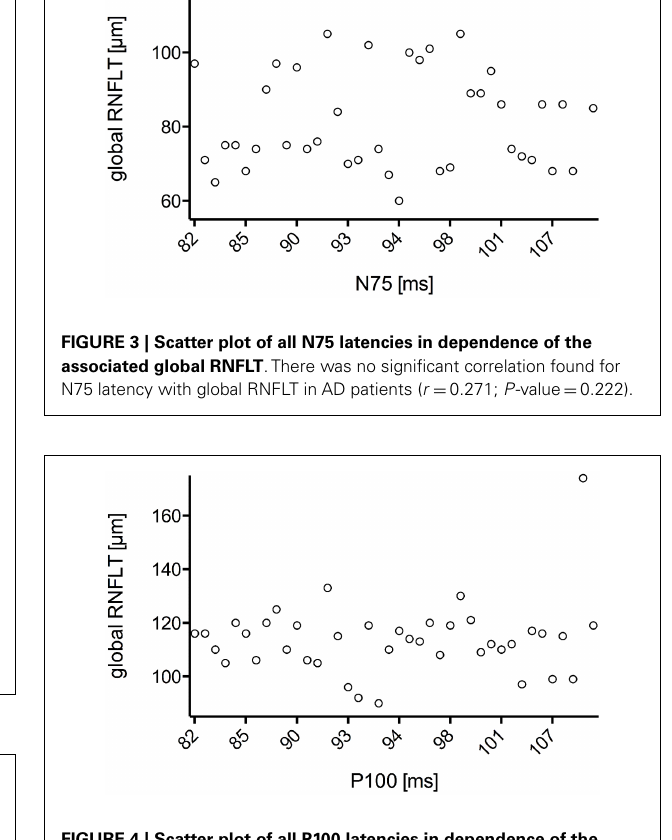
FIGURE 4 | Scatter plot of all P100 latencies in dependence of the associated global RNFLT .There was no significant correlation found for N75 latency with global RNFLT in AD patients ( r = 0.322; P -value =